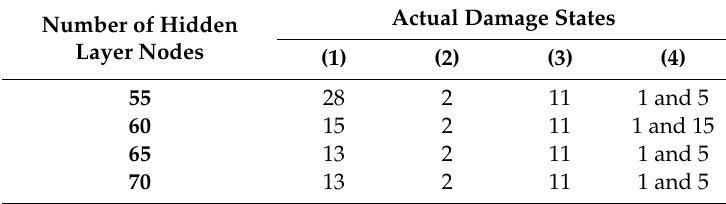
Table 8. Damage detection results of experimental data (accelerometers).